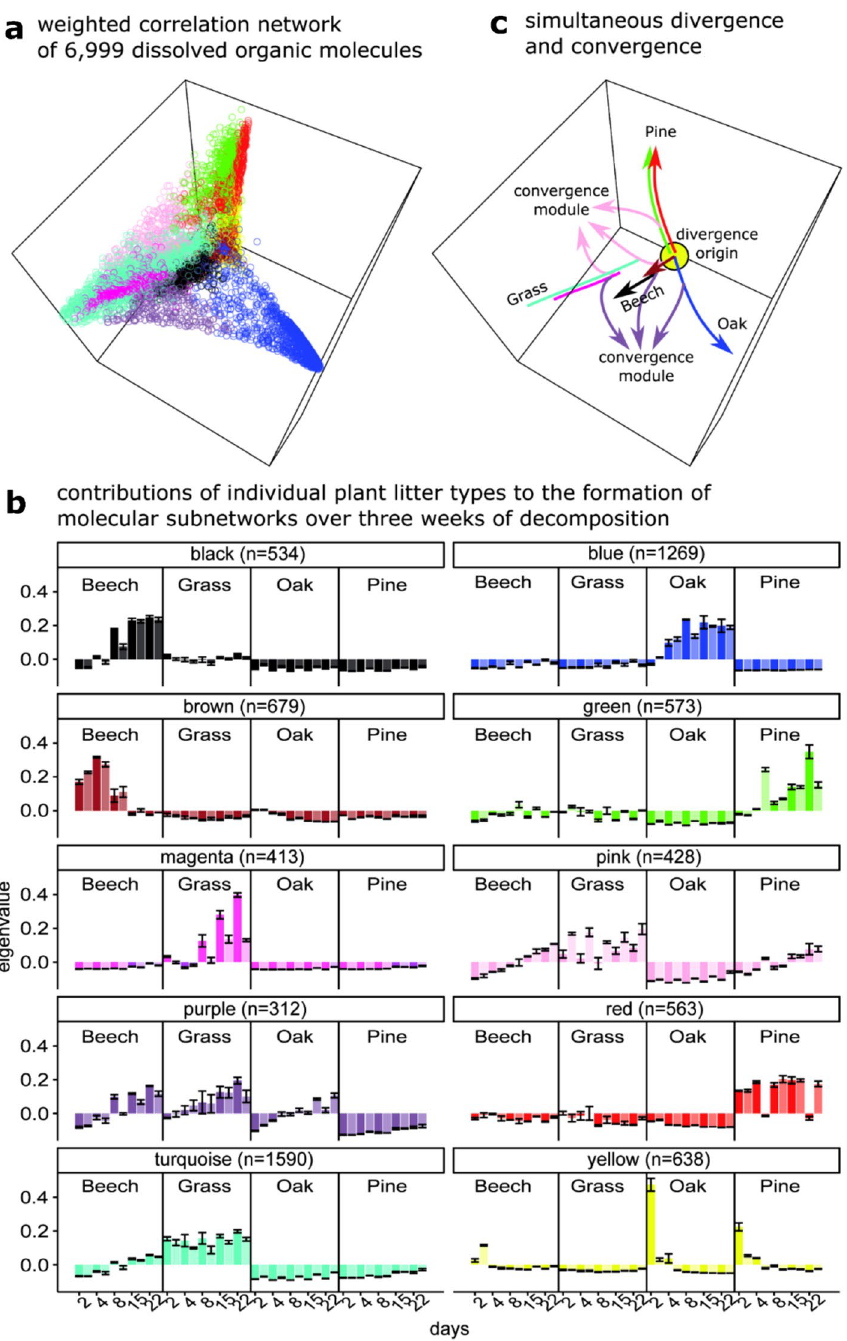
Figure 2. ( a ) Weighted correlation network analysis (WGCNA) of a combination of 6999 molecular entities in DOM scaled into three dimensions. ( b ) Contributions of the DOM samples to the network modules. The samples are grouped by litter type. Each bar summarizes three biological replicates. A lighter shade identifies bars representing samples from the Linde forest; a darker shade samples from the Hainich forest. ( c ) Summary graph indicating simultaneous divergence and convergence during litter